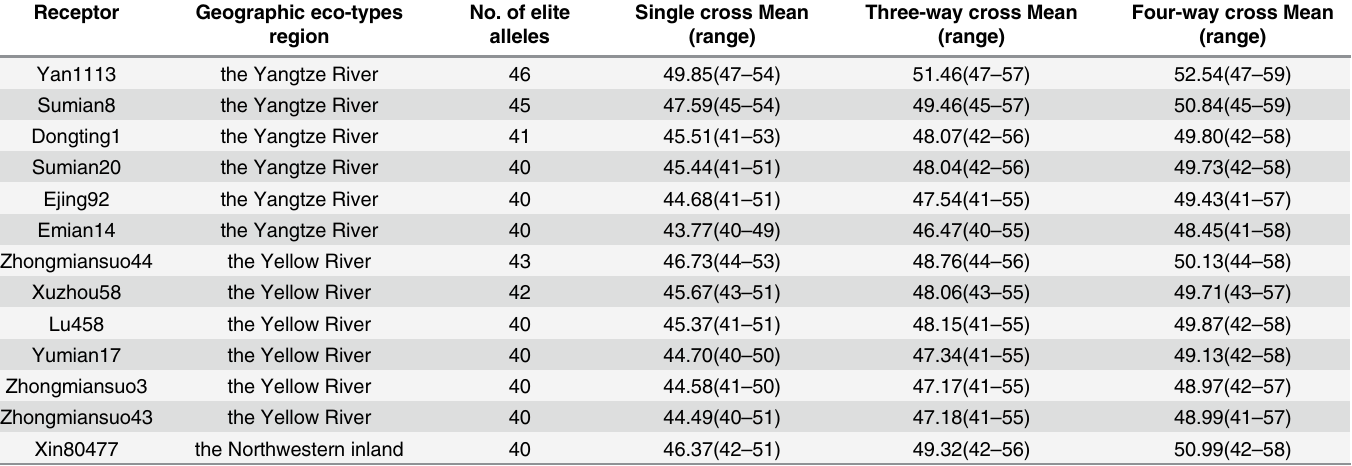
Table 3. Molecular breeding by design for pyramiding the favorable alleles by assembling the combinations with 13 salt-tolerant cultivars as receptor and other 303 accessions as donors.